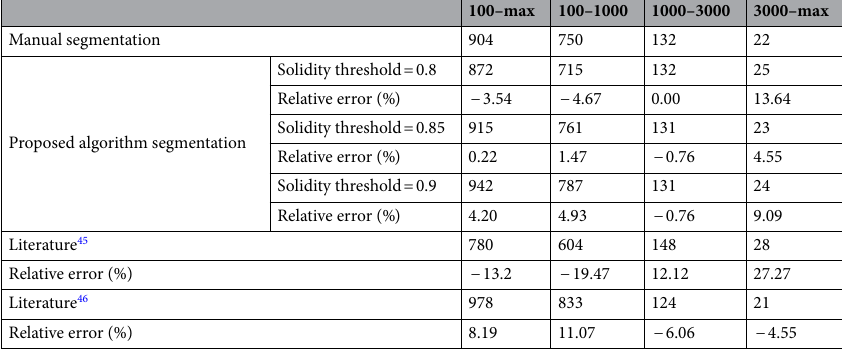
Table 4. The number of rock blocks in the image segmentation result of limestone blasted rock piles.